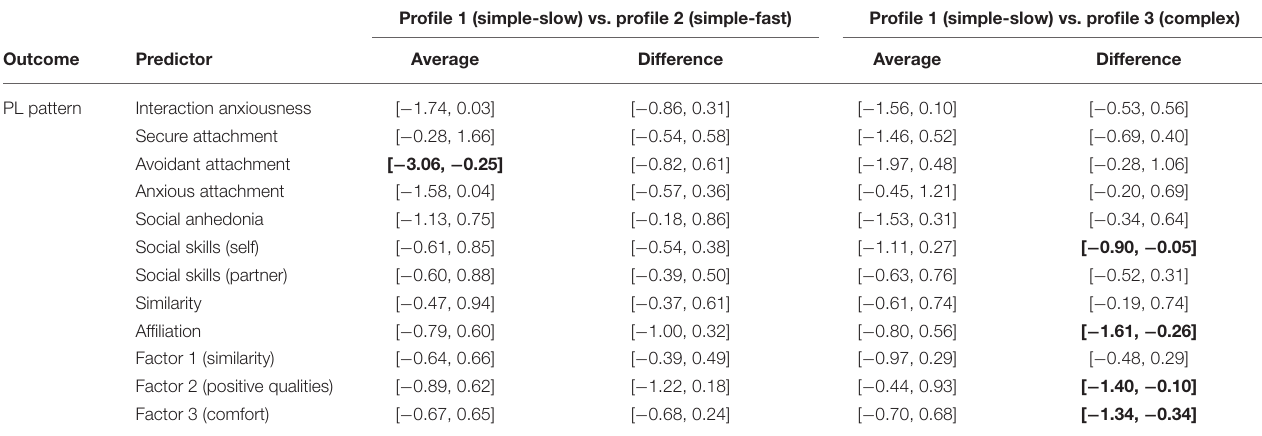
TABLE 5 | Individual-level variables predicting PL pattern. Profile 1 (simple-slow) vs. profile 2 (simple-fast)